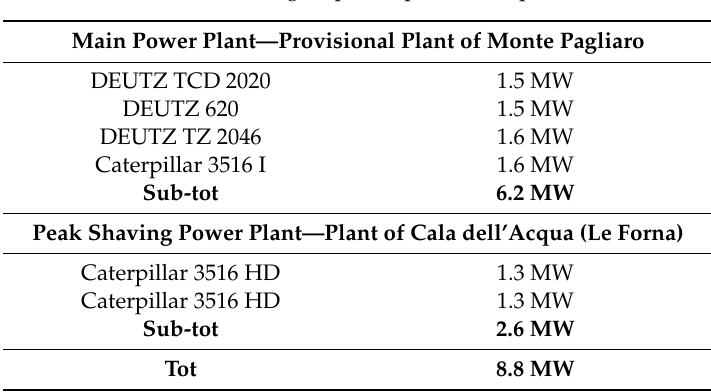
Figure 1. Ponza island map Table 2. Diesel engine power plants’